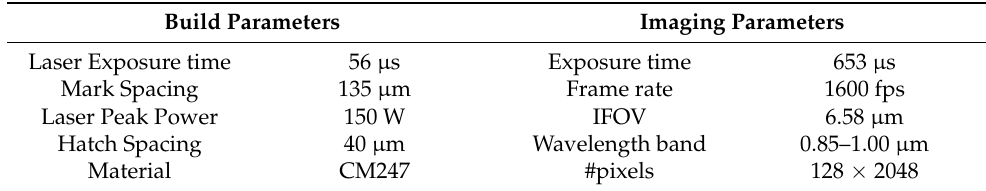
Table 1. The build parameters and imaging parameters used during the image